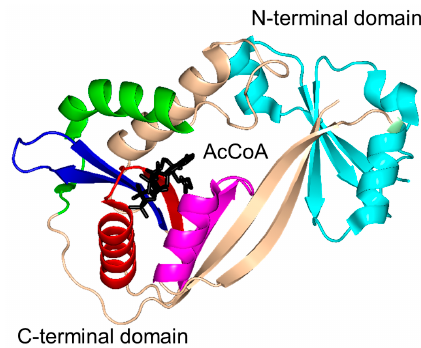
Figure 10. Cartoon representation of the structure of E. coli WecD in complex with AcCoA. The N-terminal partial GNAT domain is colored cyan (PDB ID: 2FT0 [113]). The conserved and non-conserved motifs of the GNAT domain are colored as in Figure 3.